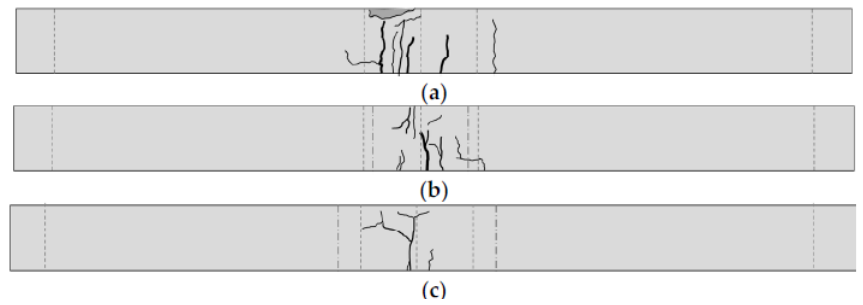
Figure 11. Crack patterns of specimens: ( a ) CRC; ( b ) PCM-A; ( c ) PCM-B.